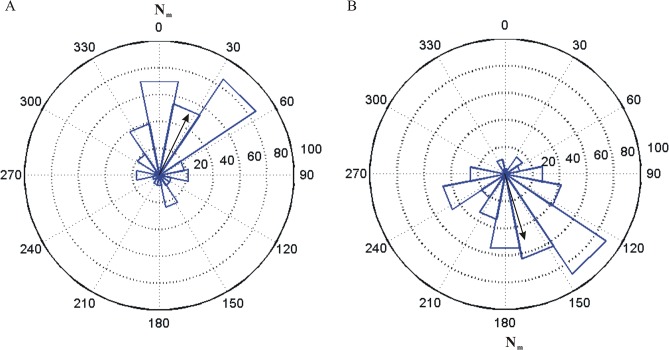
Angular histograms of roosting locations in the natural geomagnetic field (A) and a polarity reversed magnetic field (B).Field intensity is 51μT. Black arrows indicate the direction and magnitude of the mean resultant vector. Nm: magnetic north.